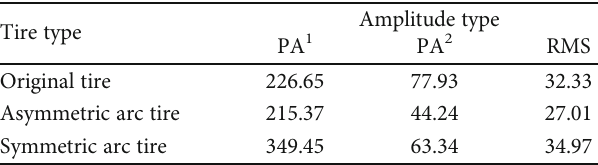
Table 2: The comparison of vibration amplitudes of three kinds of